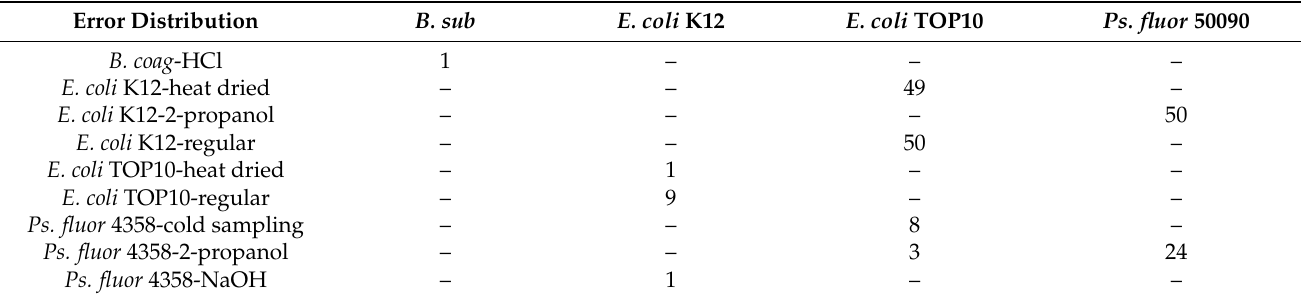
Table 3. Detailed analysis of the classification errors of the independent test data set on the sub-dataset level. The numbers are the total numbers of misclassified spectra in the specific